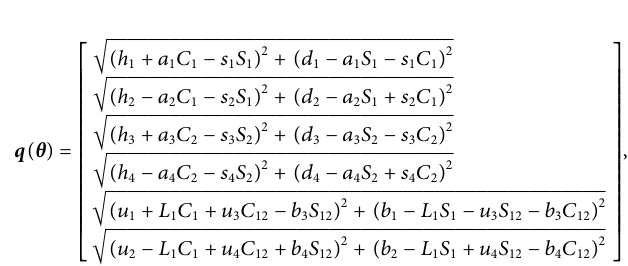
FIGURE 1 | Musculoskeletal